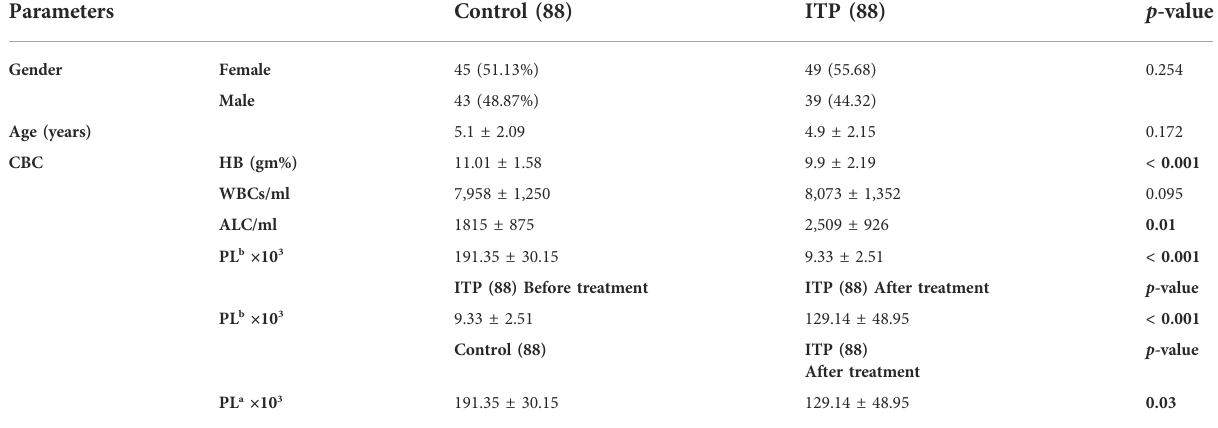
TABLE 1 Comparison between ITP children and healthy control children regarding gender, age, and some blood smear parameters.